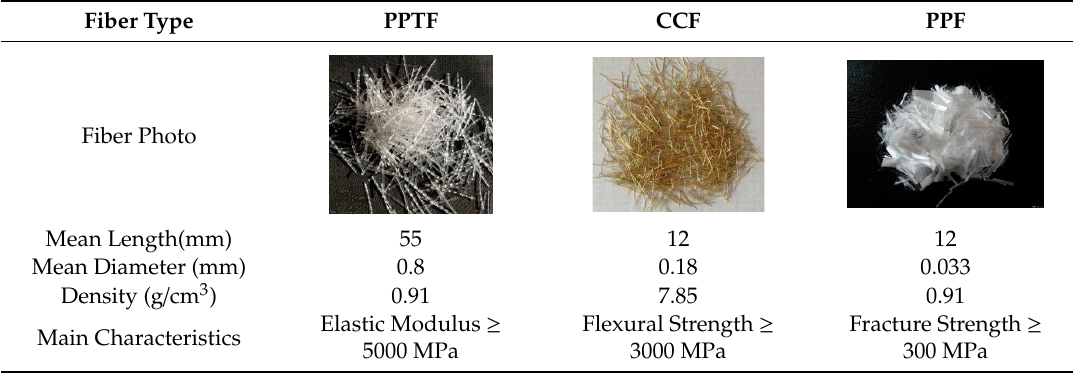
Table 4. Mix proportions of pervious